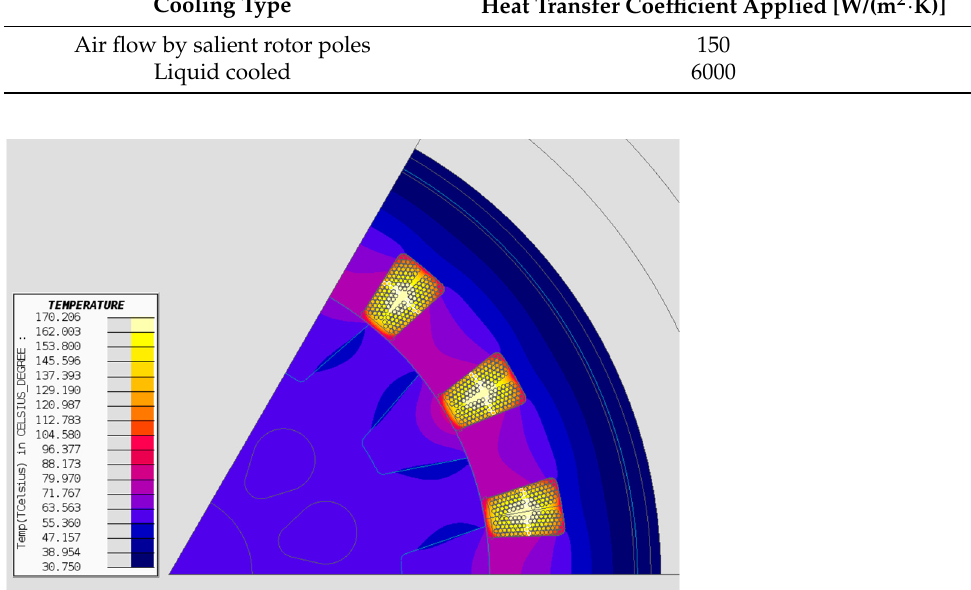
Figure 26. Steady-state thermal FEA result for LSA SRM at the base speed and maximum continuous power. Table 9. Heat Transfer Coefficients Guideline.